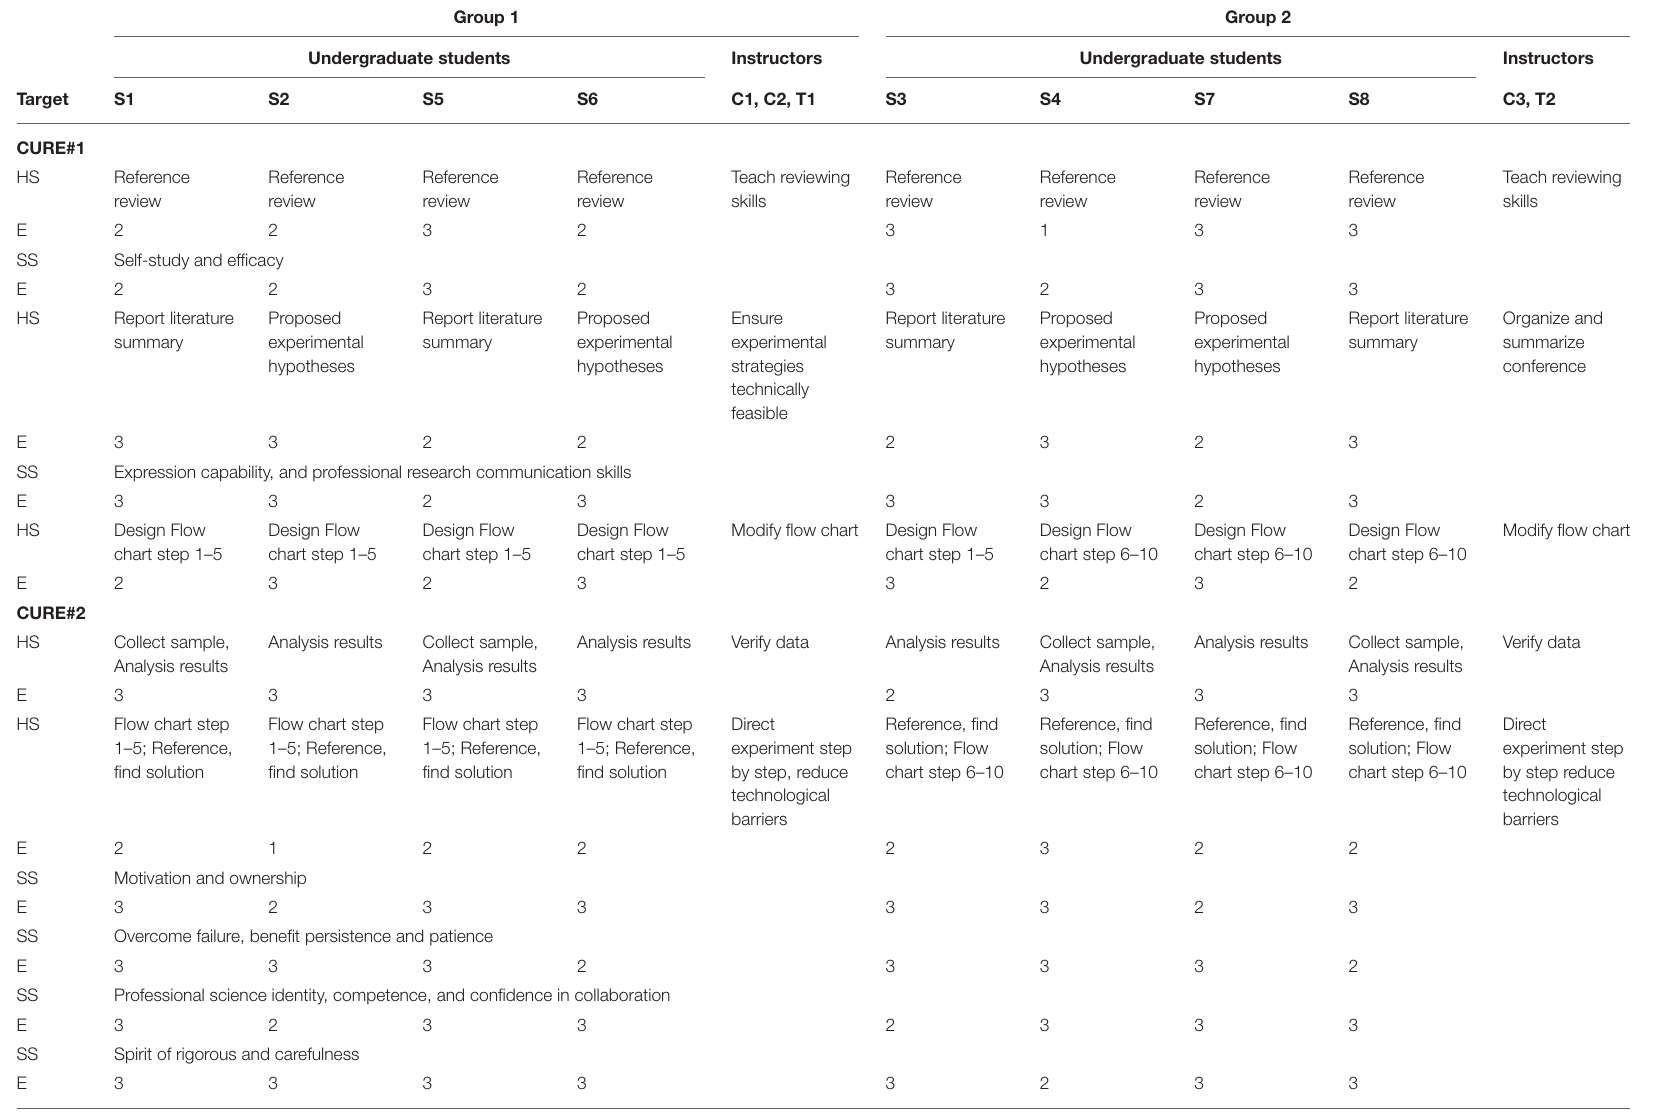
TABLE 3 | Evaluation by students and instructors over CUREs